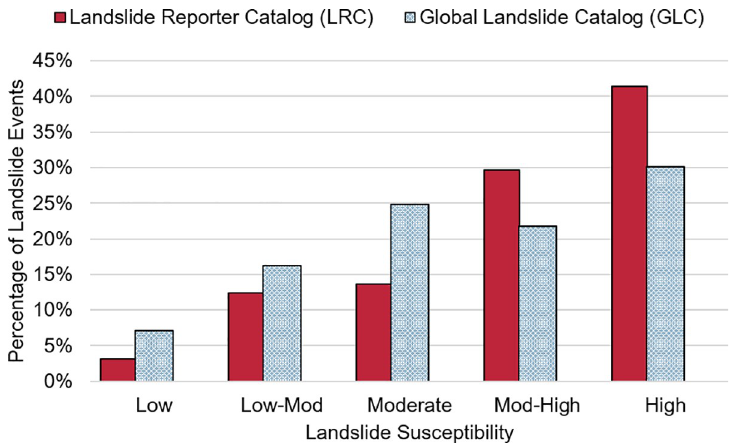
Fig 10. Modeled landslide susceptibility associated with reported events. The landslide susceptibility value from the map produced by Stanley and Kirschbaum [15,57] associated with each LRC (in red) and GLC point (in blue). The events are located on areas of low landslide susceptibility to high landslide